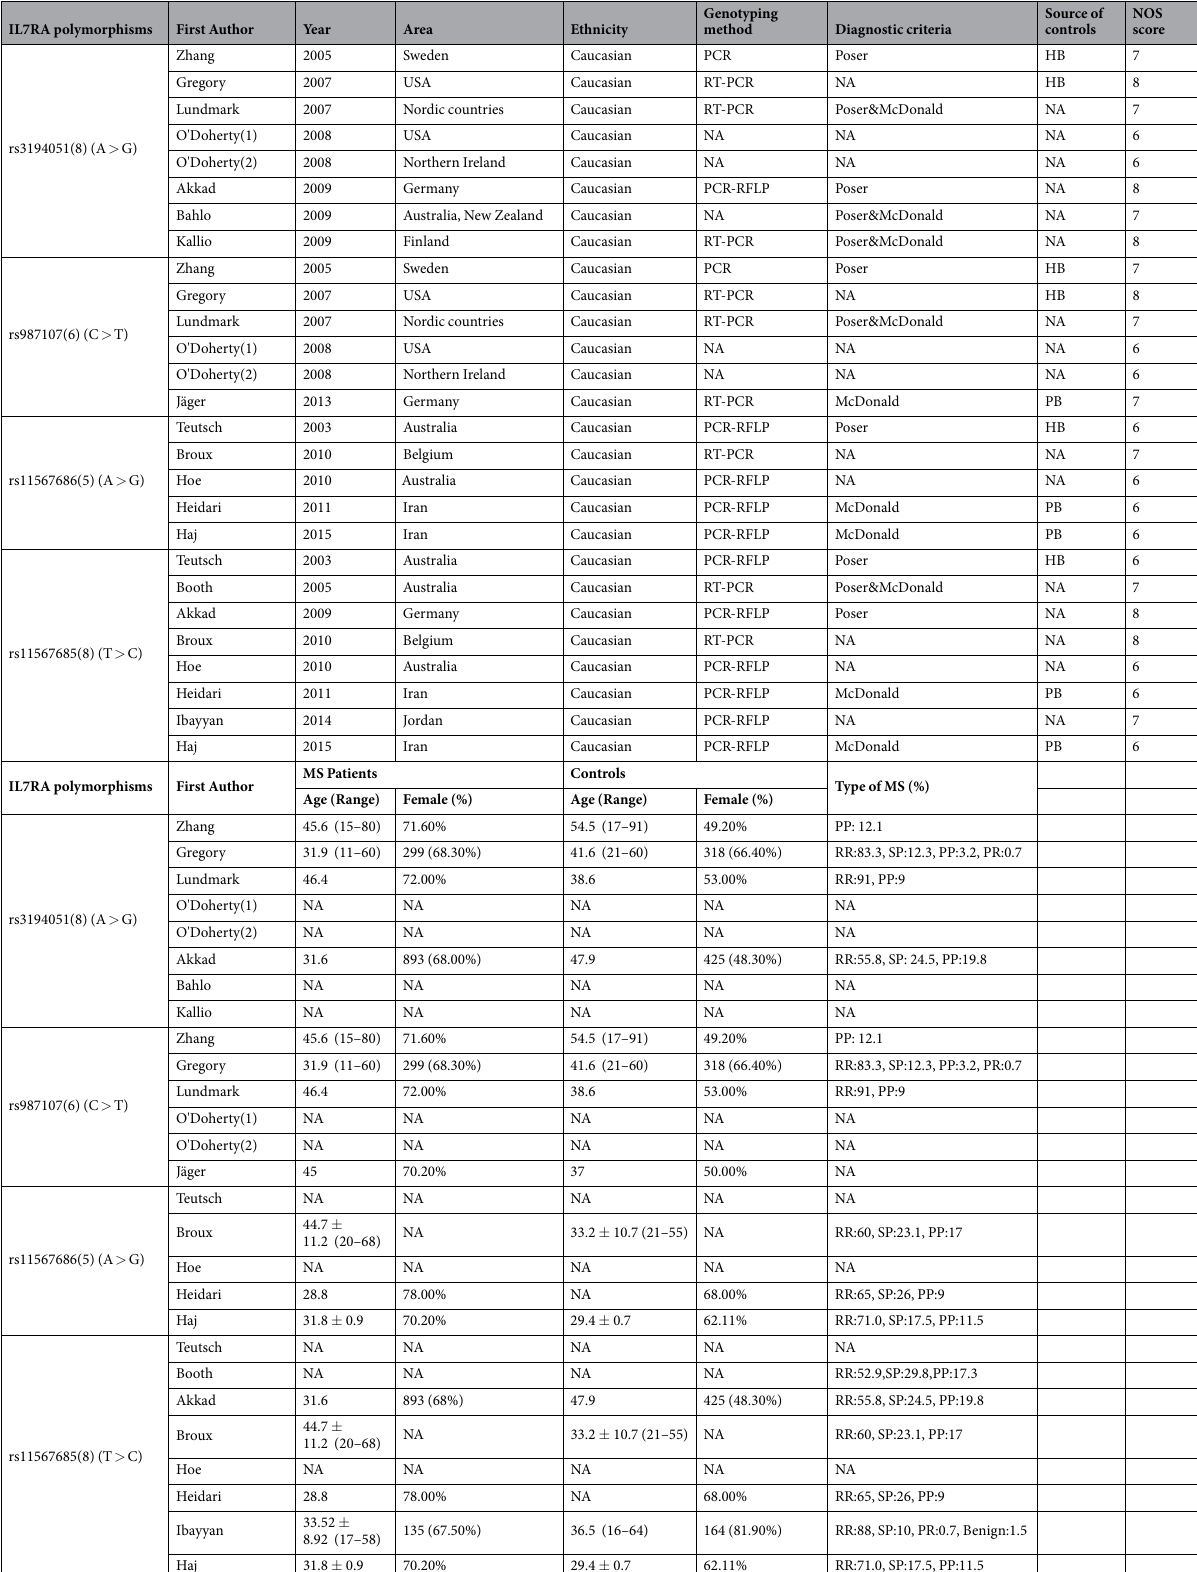
RR:71.0, SP:17.5, PP:11.5